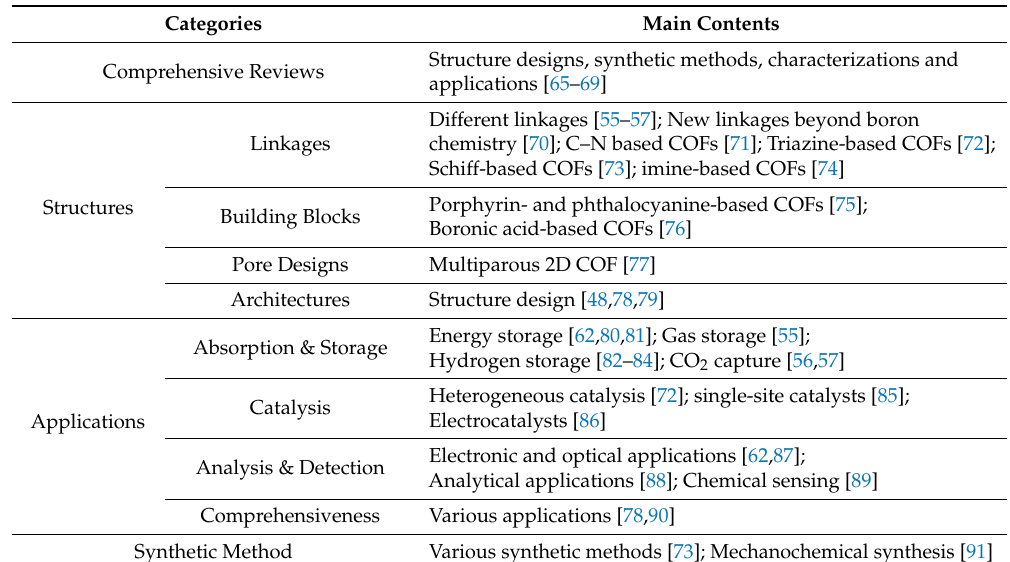
Table 1. Previous reviews of covalent organic frameworks (COFs).